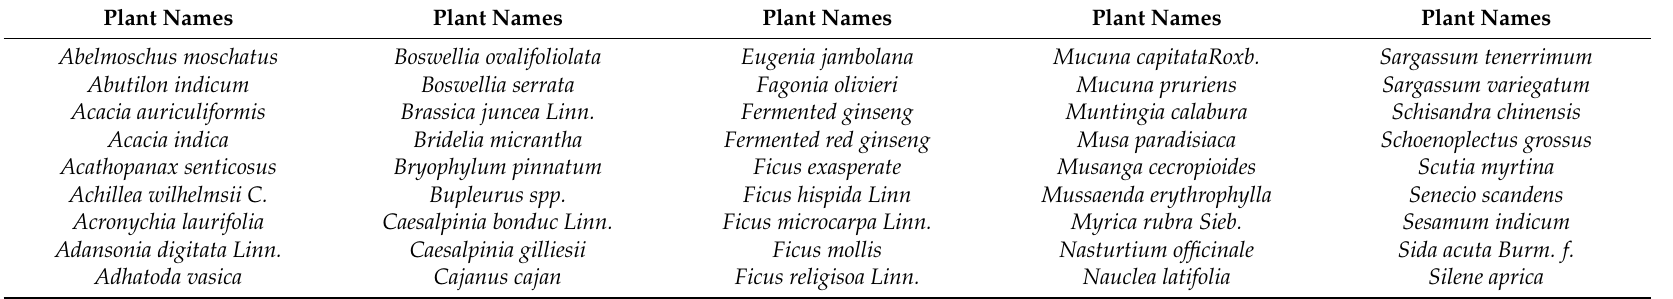
Table 4. The medicinal plants showed to ameliorate the acetaminophen-induced hepatotoxicity in different models. Plant